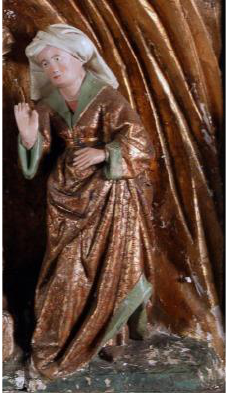
Figure 4. Details showing Ólöf the Rich as she appears in the altarpiece at Skarð.